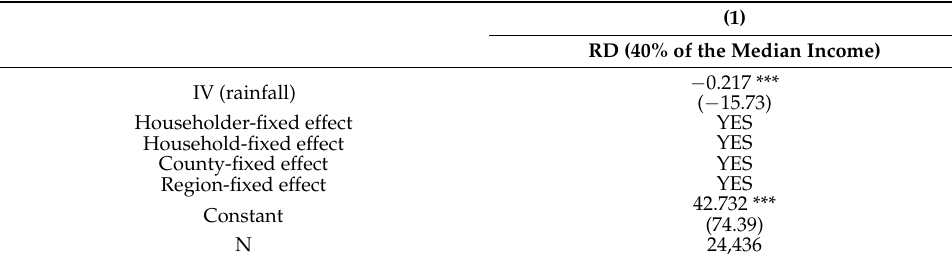
Table A1. Results of the first regression in the IV